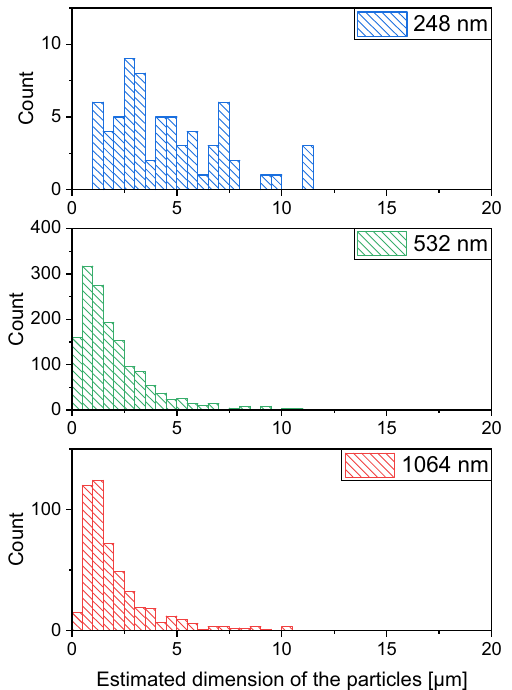
Figure 8. Size distribution of the particles generated by laser ablation at 248 nm, 532 nm and 1064 nm wavelengths. (Note the different scales on the y-axis).